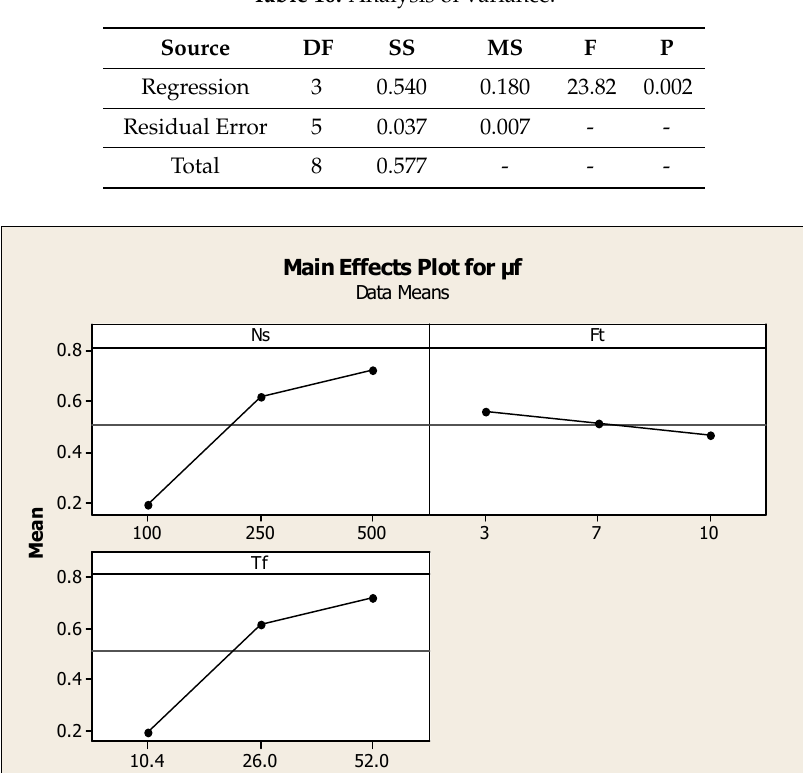
Table 11. Regression equation coefficients.